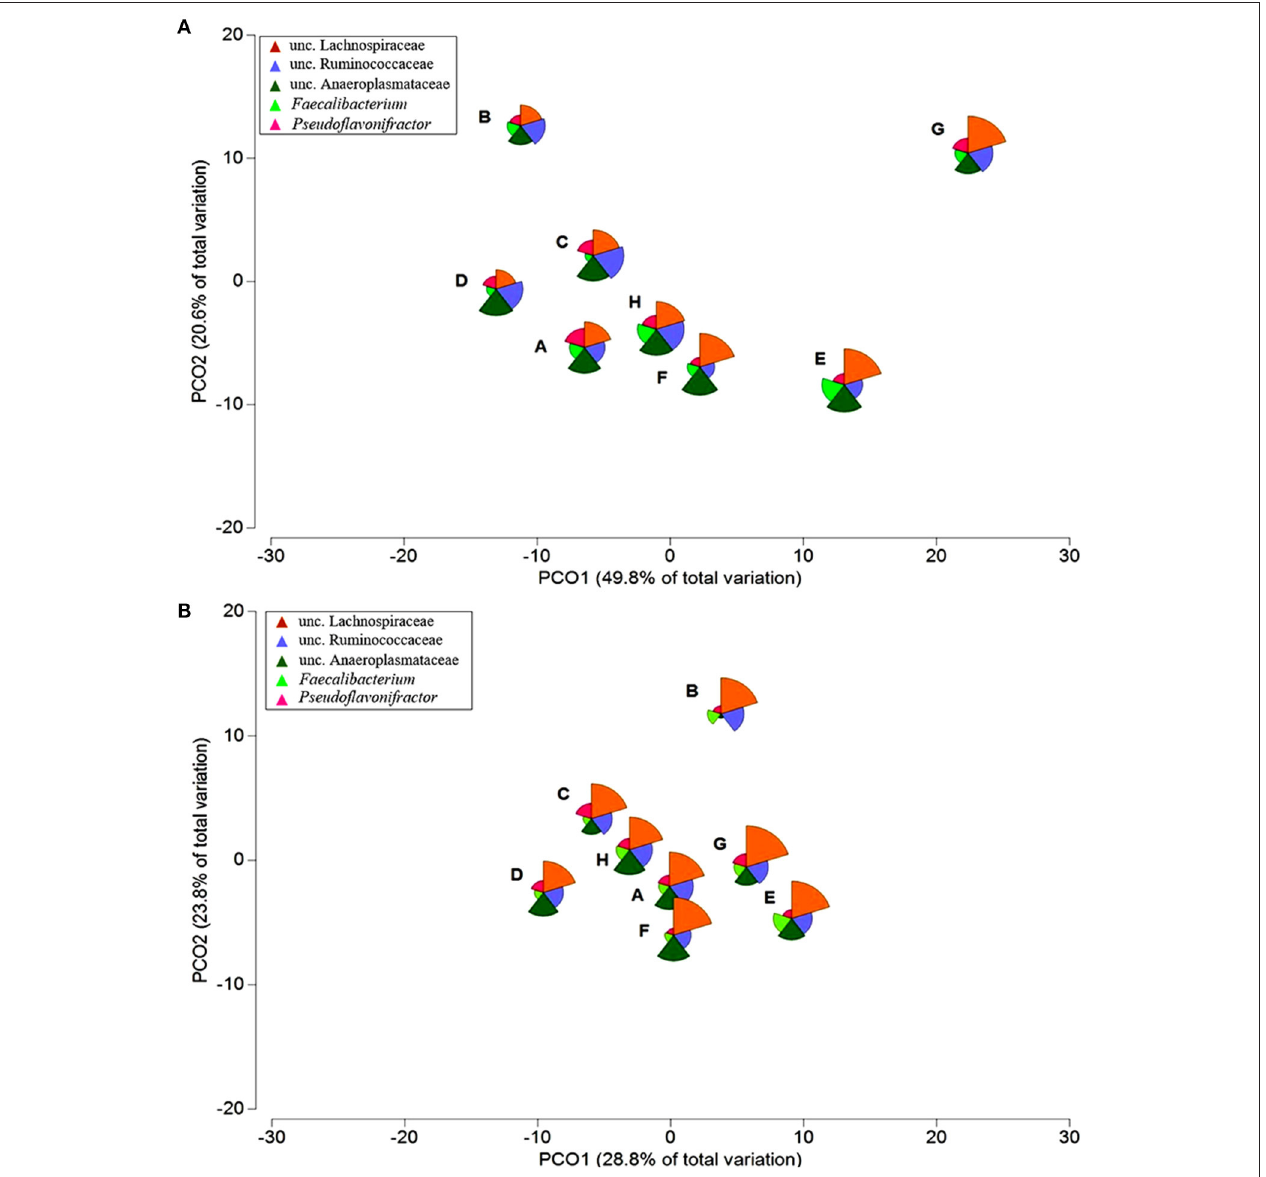
FIGURE 5 | Principal coordinate analysis (PCoA) ordination of the global bacterial community structure of caeca (A) digesta and (B) mucosa samples across eight dietary treatments (A–H) ( Table 1 ). Bubbles were superimposed to visualize the relative abundance of the most relevant genera, Faecalibacterium and Pseudoflavonifractor and families, Lachnospiraceae, Ruminococcaceae, and Anaeroplasmataceae (slice scale 1–30%